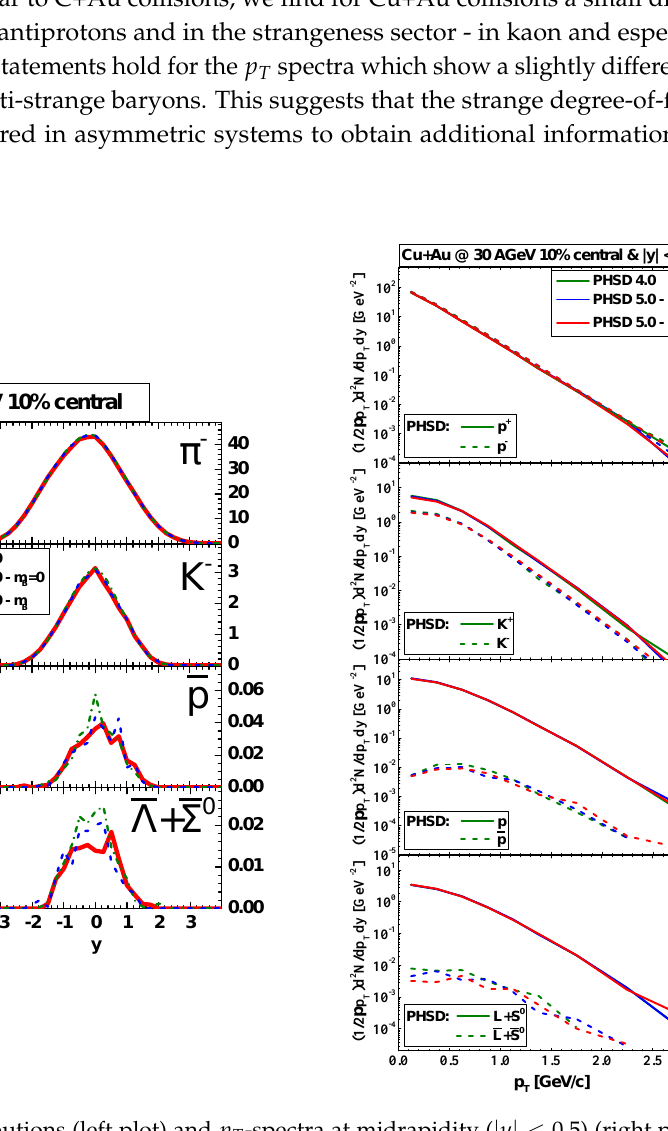
Figure 3. The rapidity distributions (left plot) and p T -spectra at midrapidity ( | y | < 0.5) (right plot) for π ± , K ± , p , ¯ p , Λ + Σ 0 , ¯ Λ + ¯ Σ 0 for 10% central Cu+Au collisions at 30 A GeV for PHSD4.0 (green dot-dashed lines), PHSD5.0 with partonic cross sections and parton masses calculated for µ B = 0 (blue dashed lines) and with cross sections and parton masses evaluated at the actual chemical potential µ B in each individual space-time cell (red